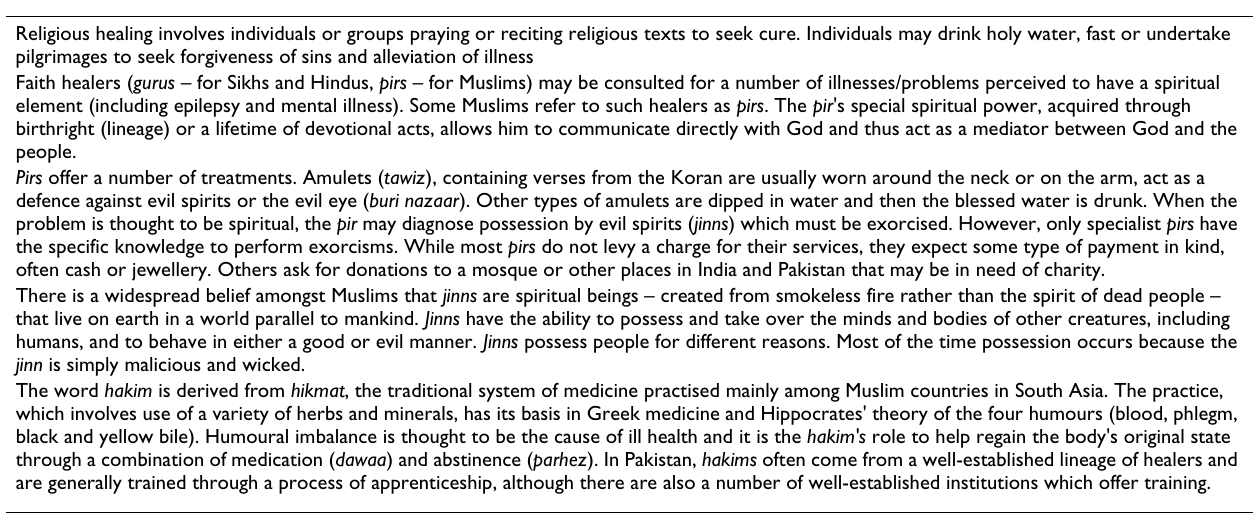
Table 1: Features of the folk system Religious healing involves individuals or groups praying or reciting religious texts to seek cure. Individuals may drink holy water, fast or undertake pilgrimages to seek forgiveness of sins and alleviation of illness Faith healers ( gurus – for Sikhs and Hindus, pirs – for Muslims) may be consulted for a number of illnesses/problems perceived to have a spiritual element (including epilepsy and mental illness). Some Muslims refer to such healers as pirs . The pir 's special spiritual power, acquired through birthright (lineage) or a lifetime of devotional acts, allows him to communicate directly with God and thus act as a mediator between God and the people. Pirs offer a number of treatments. Amulets ( tawiz ), containing verses from the Koran are usually worn around the neck or on the arm, act as a defence against evil spirits or the evil eye ( buri nazaar ). Other types of amulets are dipped in water and then the blessed water is drunk. When the problem is thought to be spiritual, the pir may diagnose possession by evil spirits ( jinns ) which must be exorcised. However, only specialist pirs have the specific knowledge to perform exorcisms. While most pirs do not levy a charge for their services, they expect some type of payment in kind, often cash or jewellery. Others ask for donations to a mosque or other places in India and Pakistan that may be in need of charity. There is a widespread belief amongst Muslims that jinns are spiritual beings – created from smokeless fire rather than the spirit of dead people – that live on earth in a world parallel to mankind. Jinns have the ability to possess and take over the minds and bodies of other creatures, including humans, and to behave in either a good or evil manner. Jinns possess people for different reasons. Most of the time possession occurs because the jinn is simply malicious and wicked. The word hakim is derived from hikmat , the traditional system of medicine practised mainly among Muslim countries in South Asia. The practice, which involves use of a variety of herbs and minerals, has its basis in Greek medicine and Hippocrates' theory of the four humours (blood, phlegm, black and yellow bile). Humoural imbalance is thought to be the cause of ill health and it is the hakim's role to help regain the body's original state through a combination of medication ( dawaa ) and abstinence ( parhez ). In Pakistan, hakims often come from a well-established lineage of healers and are generally trained through a process of apprenticeship, although there are also a number of well-established institutions which offer